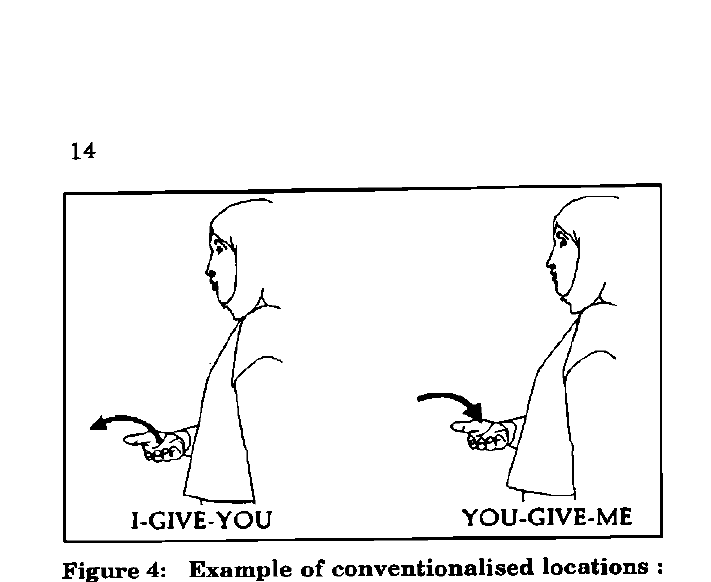
Figure 4: Example of conventionalised locations : verb inflections.